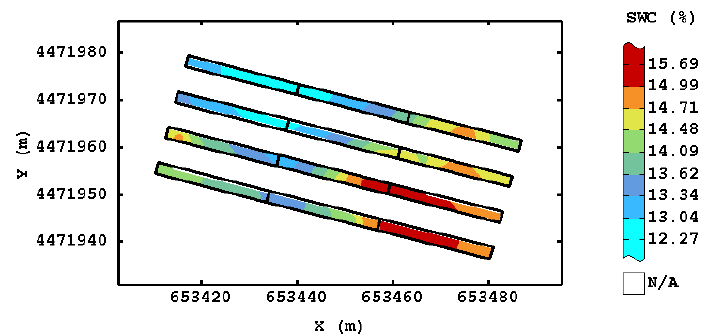
Figure 2. Spatial estimates of gravimetric SWC obtained with ordinary kriging (OK). Color scale uses iso-frequency classes.